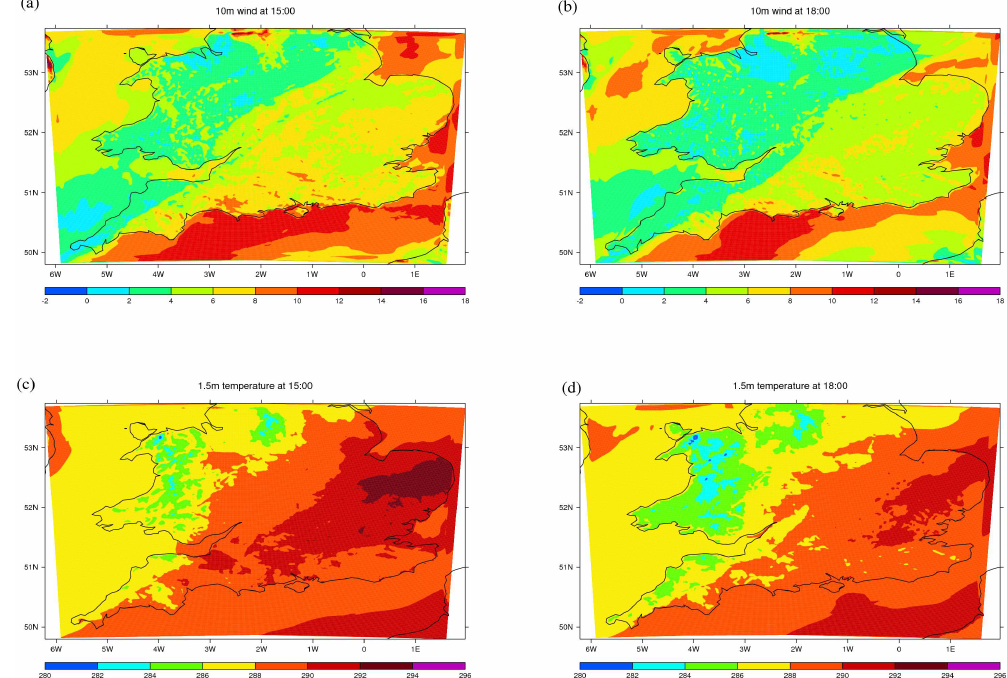
Fig. 6. Control forecast. Left column: 15:00UTC ( T + 3), right column: 18:00UTC ( T + 6) 20 September 2011. Top row: 10m wind speed (ms − 1 ), bottom row: 1.5m temperature (K). Table 2. Summary of model configurations for the ensemble